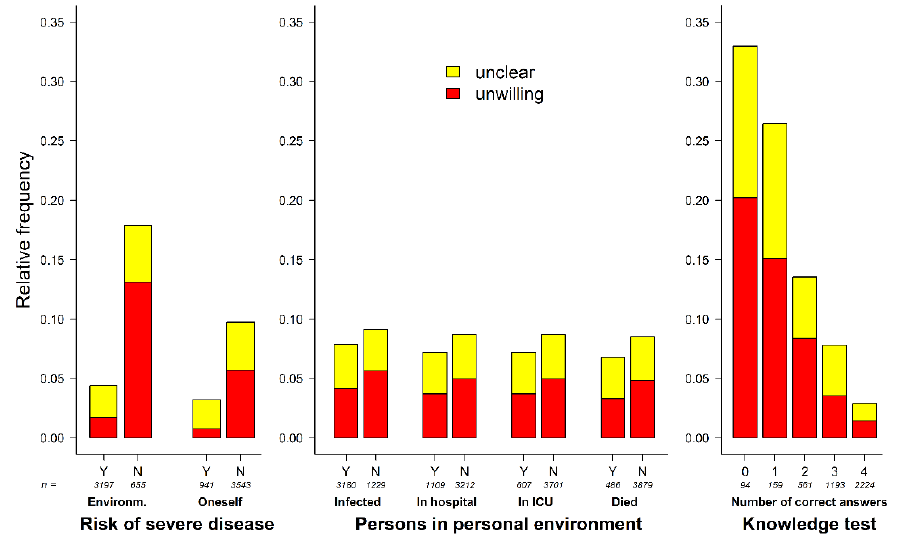
Figure 7. Perceived risk of severe COVID-19 disease, history of infections in personal environment and knowledge of COVID-19 vaccines. Abbreviations: ICU, intensive care unit; environm., environment; Y, yes; N, no. Risk of severe disease for oneself (totally agree to totally disagree) was dichotomized for visualization. Category “I do not know” was not visualized. All data are given in Table S5.